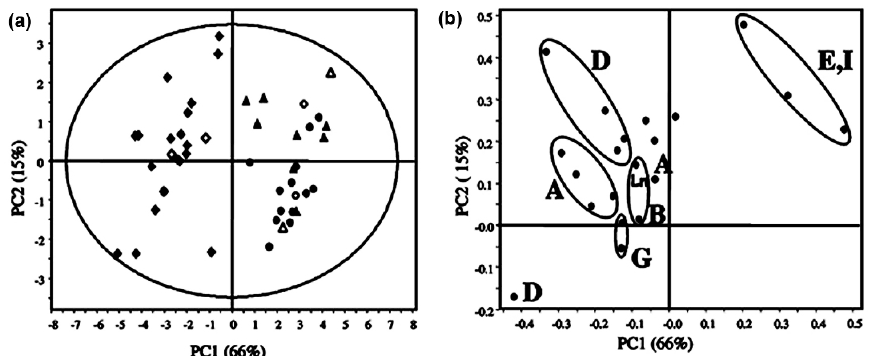
Figure 37. PCA of the 1 H-NMR resonances of lipid fractions: ( a ) score plot of PC1 vs. PC2 [training set ( (cid:117) ) alpine farms; ( • ) lowland industrialized factories, ( (cid:78) ) mountain industrialized factories; test set ( ♦ ) alpine farms; ( ) lowland industrialized factories, ( (cid:52) ) mountain industrialized factories]; ( b ) loadings (cid:35) profile (letters correspond to Figure 36). Adopted, with permission, from [189]. Copyright 2008, American Chemical